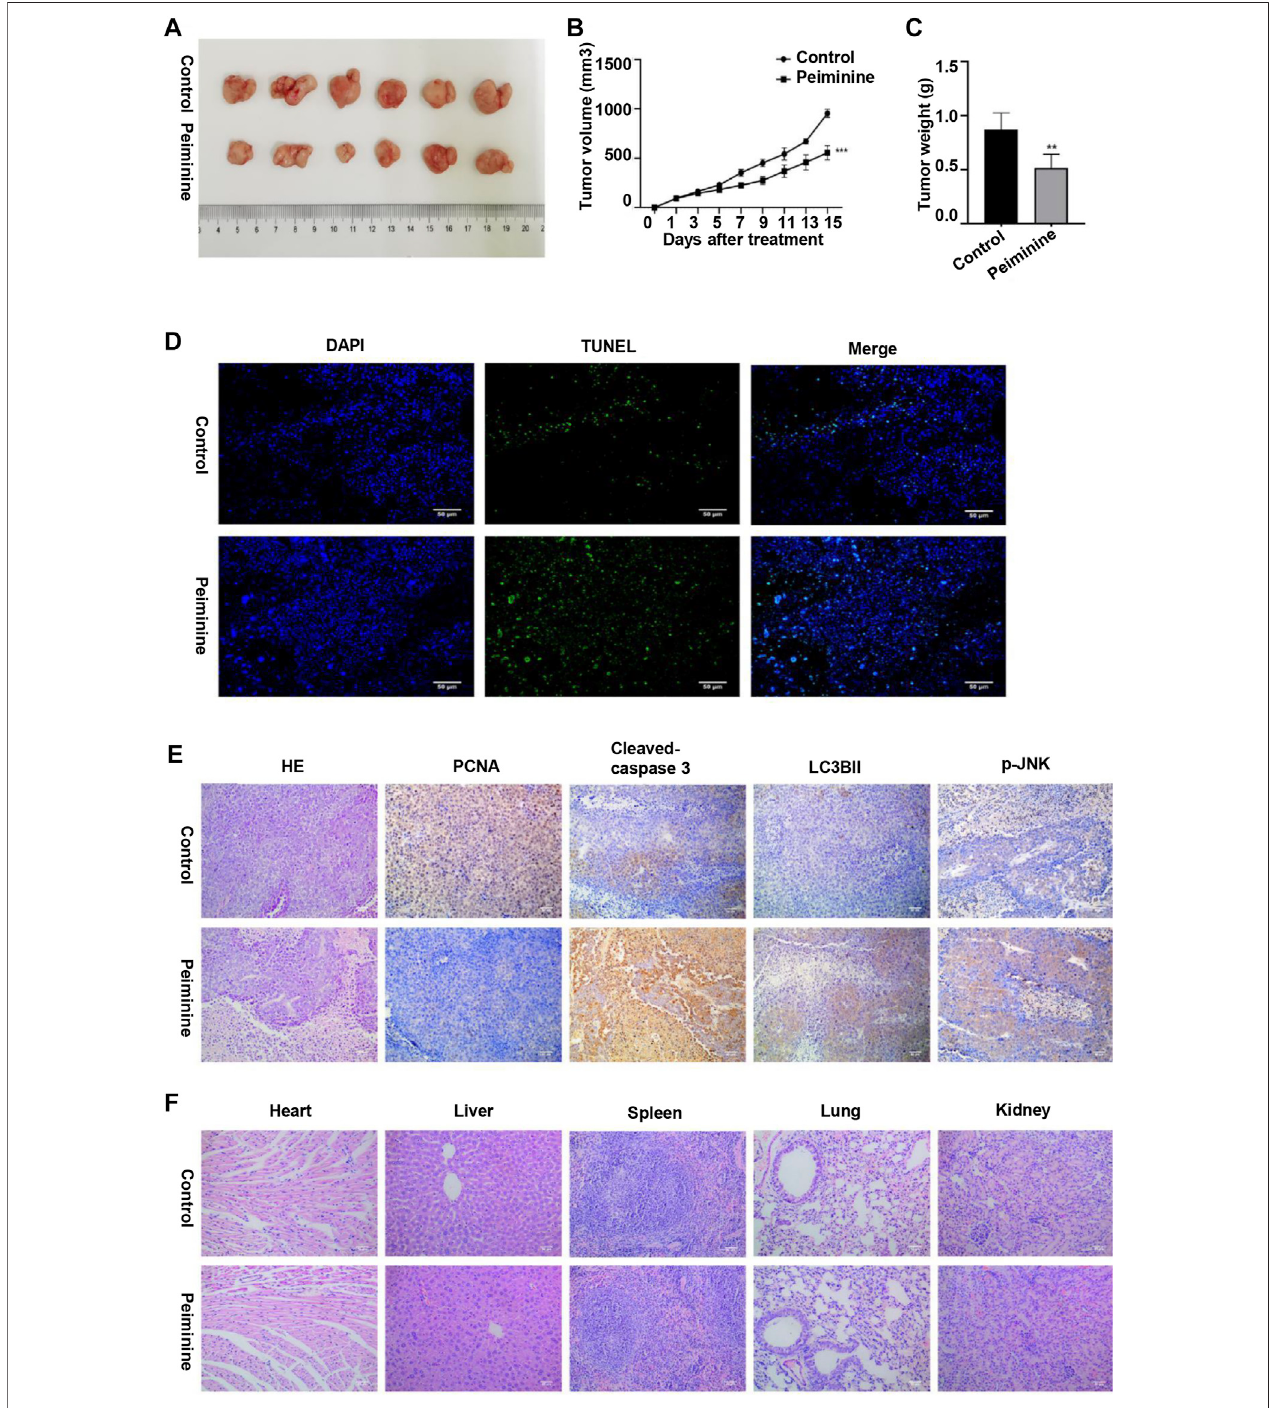
FIGURE 8 | Peiminine inhibited osteosarcoma growth in vivo . (A) Representative images of the xenografts of MG-63 cells in control or peiminine-treated mice ( n (cid:2) 6). (B) Tumor volume was measured every other day after treatment. (C) Tumor weight was analyzed once all the tumors had been isolated. (D) Apoptosis in tumor tissues was determined by TUNEL assay. TUNEL-positive cells are stained green and nuclei are stained blue (DAPI). (E) The expression of PCNA, cleaved caspase-3, LC3BII,andp-JNKwasexaminedbyimmunohistochemistry. (F) Hematoxylinandeosin(H&E)stainingwasusedtoassessthehistologyofthemajororgans.Scale bars (cid:2) 50 μ m. ** p < 0.01, *** p < 0.001.